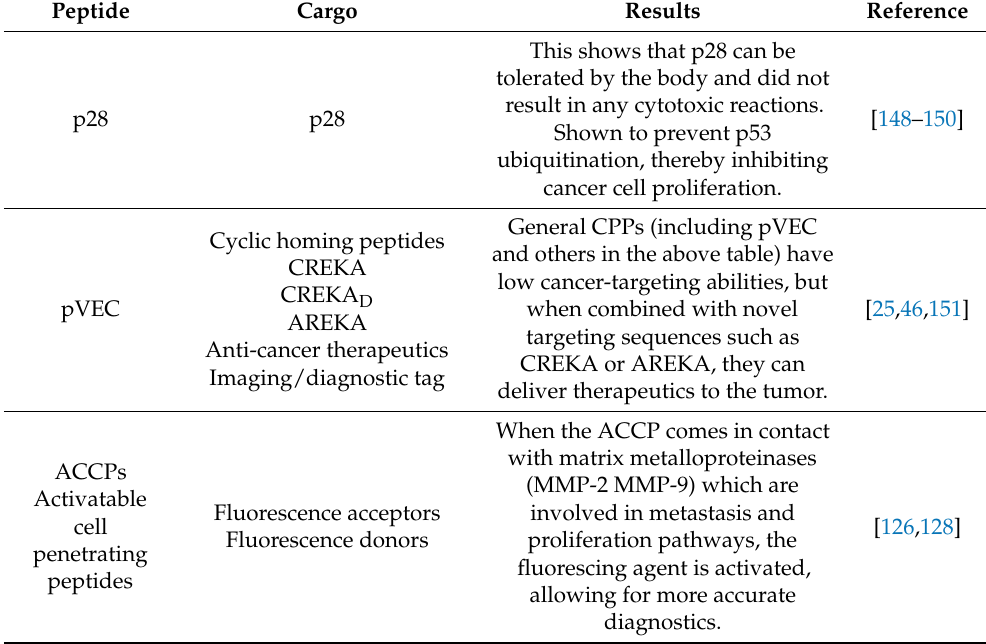
Table 2. CPPs in clinical